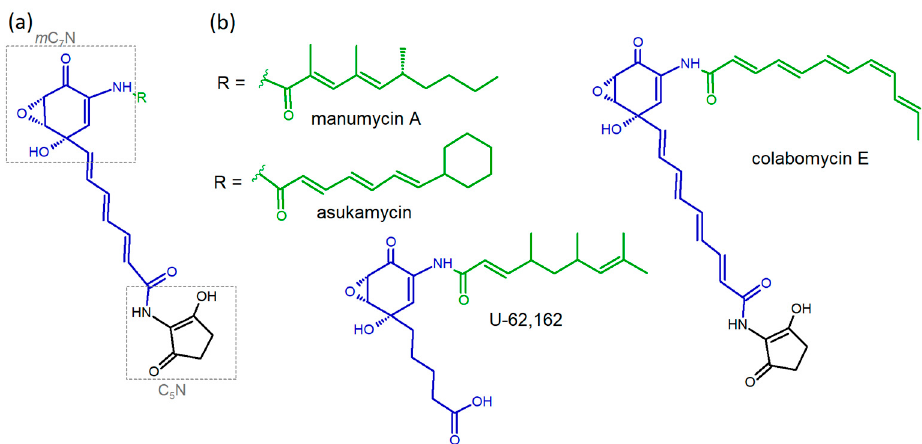
Figure 1. Manumycin-type polyketides. ( a ) General structure. Lower polyketide chains are colored in blue, upper chains in green. ( b ) Examples of variability in both polyketide chains. The lower chain contains 3,4-AHBA as a starter unit prolonged with linear, usually polyene, 4- to 8-carbon chains, but may be saturated in rare cases (U-62,162). The upper chain shows the highest variability affecting length, saturation, branching pattern, and starter unit selection.